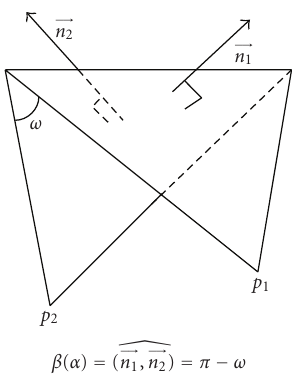
Figure 19: Patient 1. (a) 50 points on the contours, (b) 100 points on the contours, (c) 200 points on the contours, and (d) 400 points on the